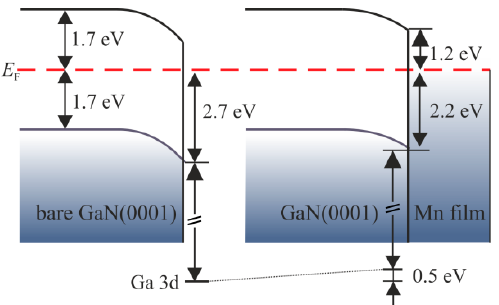
Figure 14. Energy band diagrams for bare and Mn ‐ film ‐ covered GaN(0001) surfaces. As evident, SBH can be simply calculated based on photoelectron spectroscopy measurements.